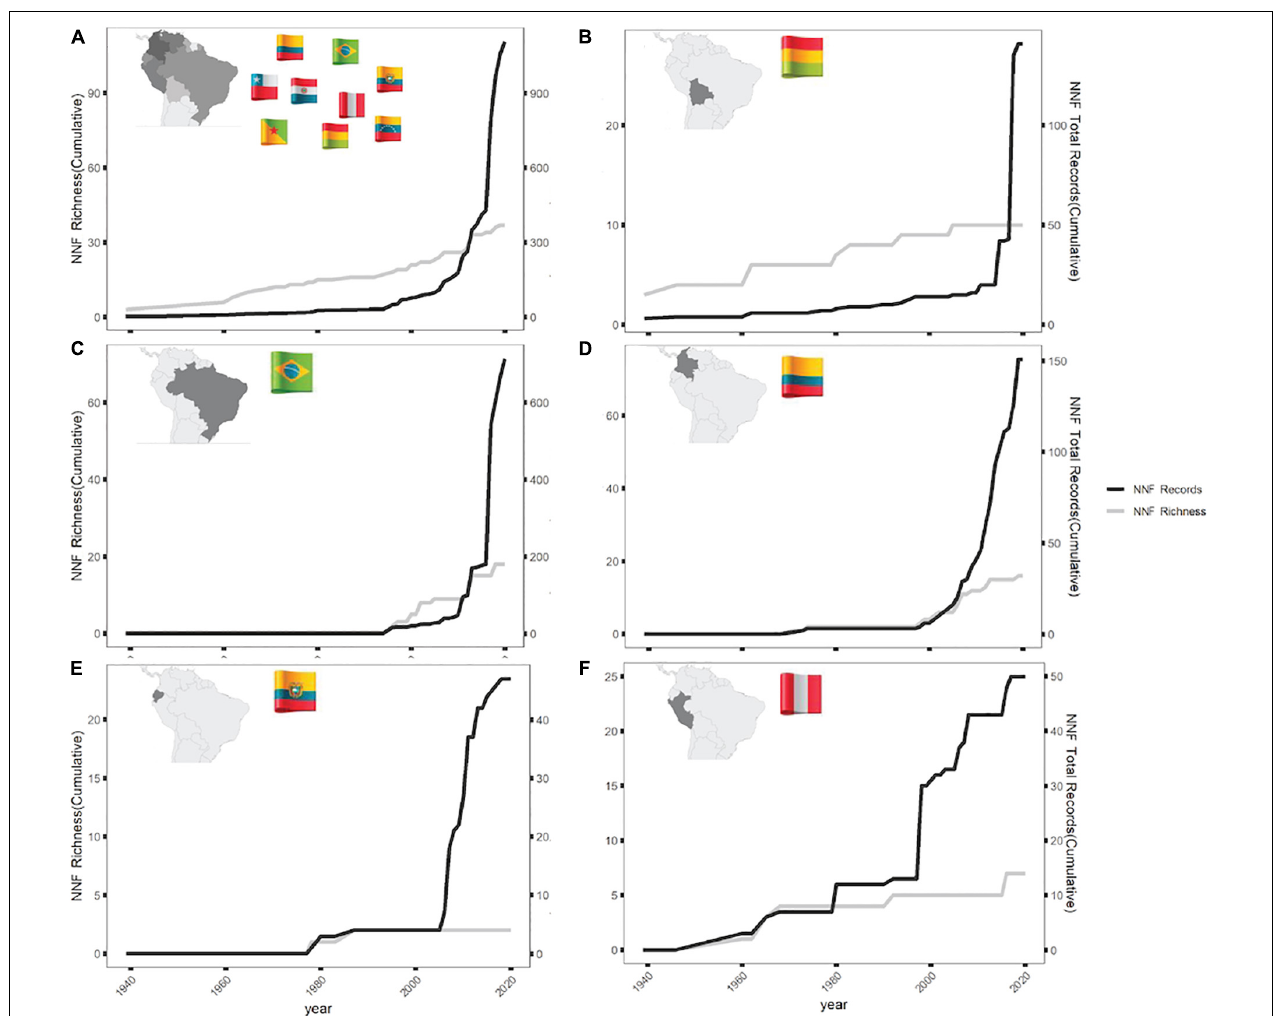
FIGURE 2 | Cumulative curve of NNF records (black lines), first occurrence records (gray lines), and overall NNF richness in the region and split by each country, which shelters part of the Amazon Region. Flags represent the country information used to build each figure (A) All countries; (B) Bolivia; (C) Brazil; (D) Colombia; (E) Ecuador; (F) Peru. Please note that Y -axis are not at the same scale to avoid hindering exponential visual trends due to scaling effects of the data. NNF, Non-Native